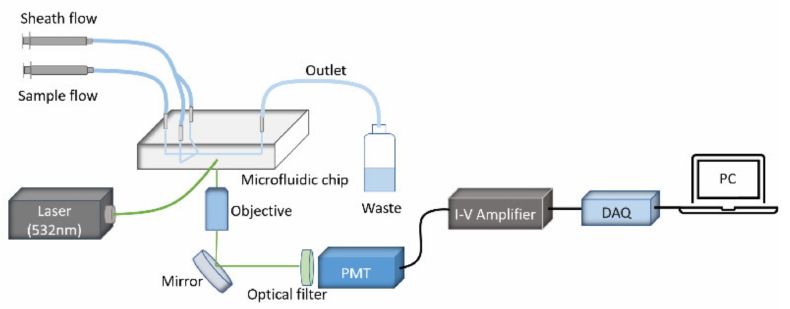
Figure 1. A schematic diagram of the microflow cytometry-based agglutination immunoassay (MCIA) setup.